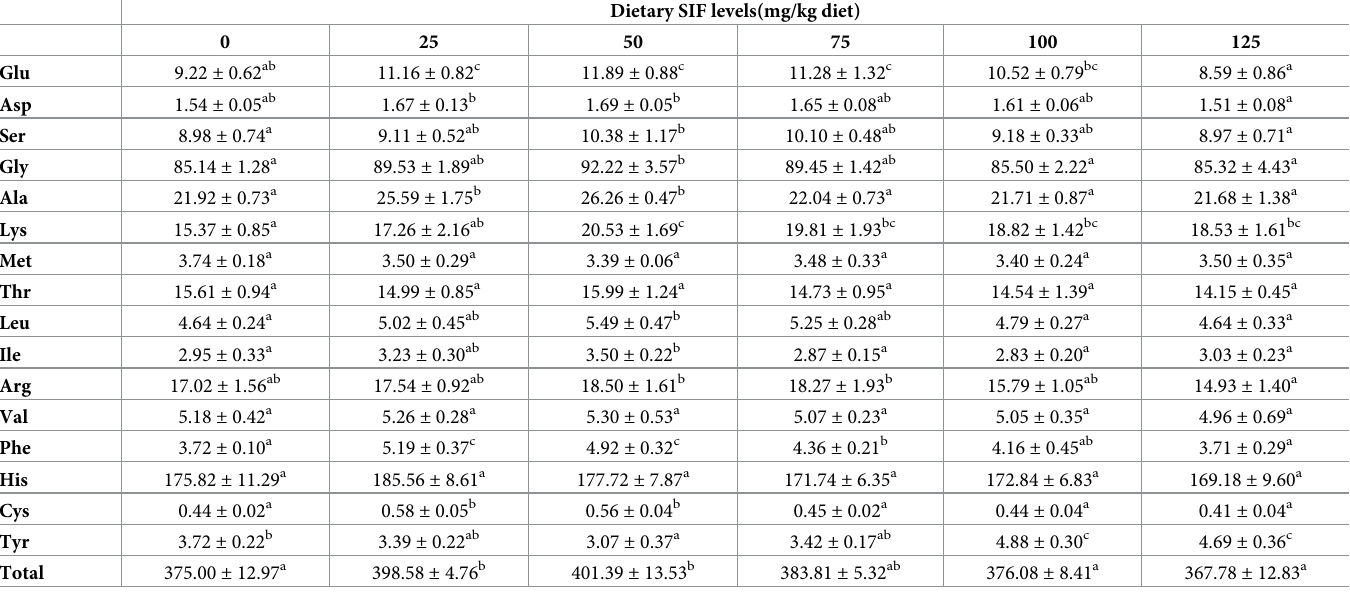
Table 5. Effects of dietary SIF supplementation (mg/kg) on muscle amino acid composition (mg/100 g tissue) of grass carp 1 . Dietary SIF levels(mg/kg